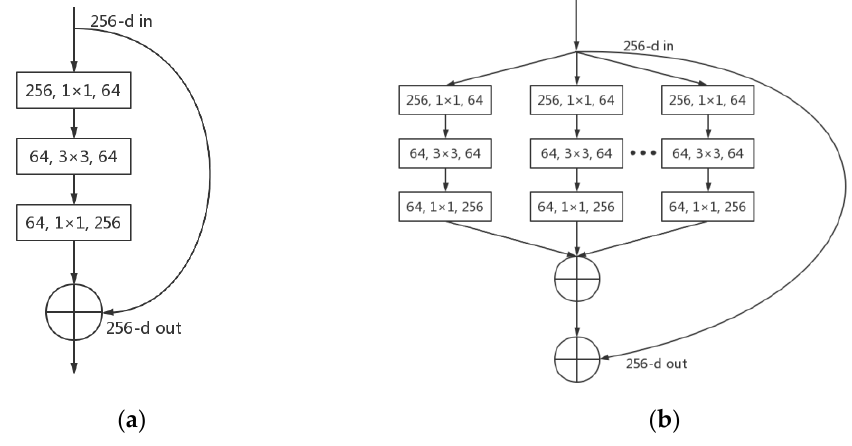
Figure 5. Building blocks of ( a ) ResNet and ( b )